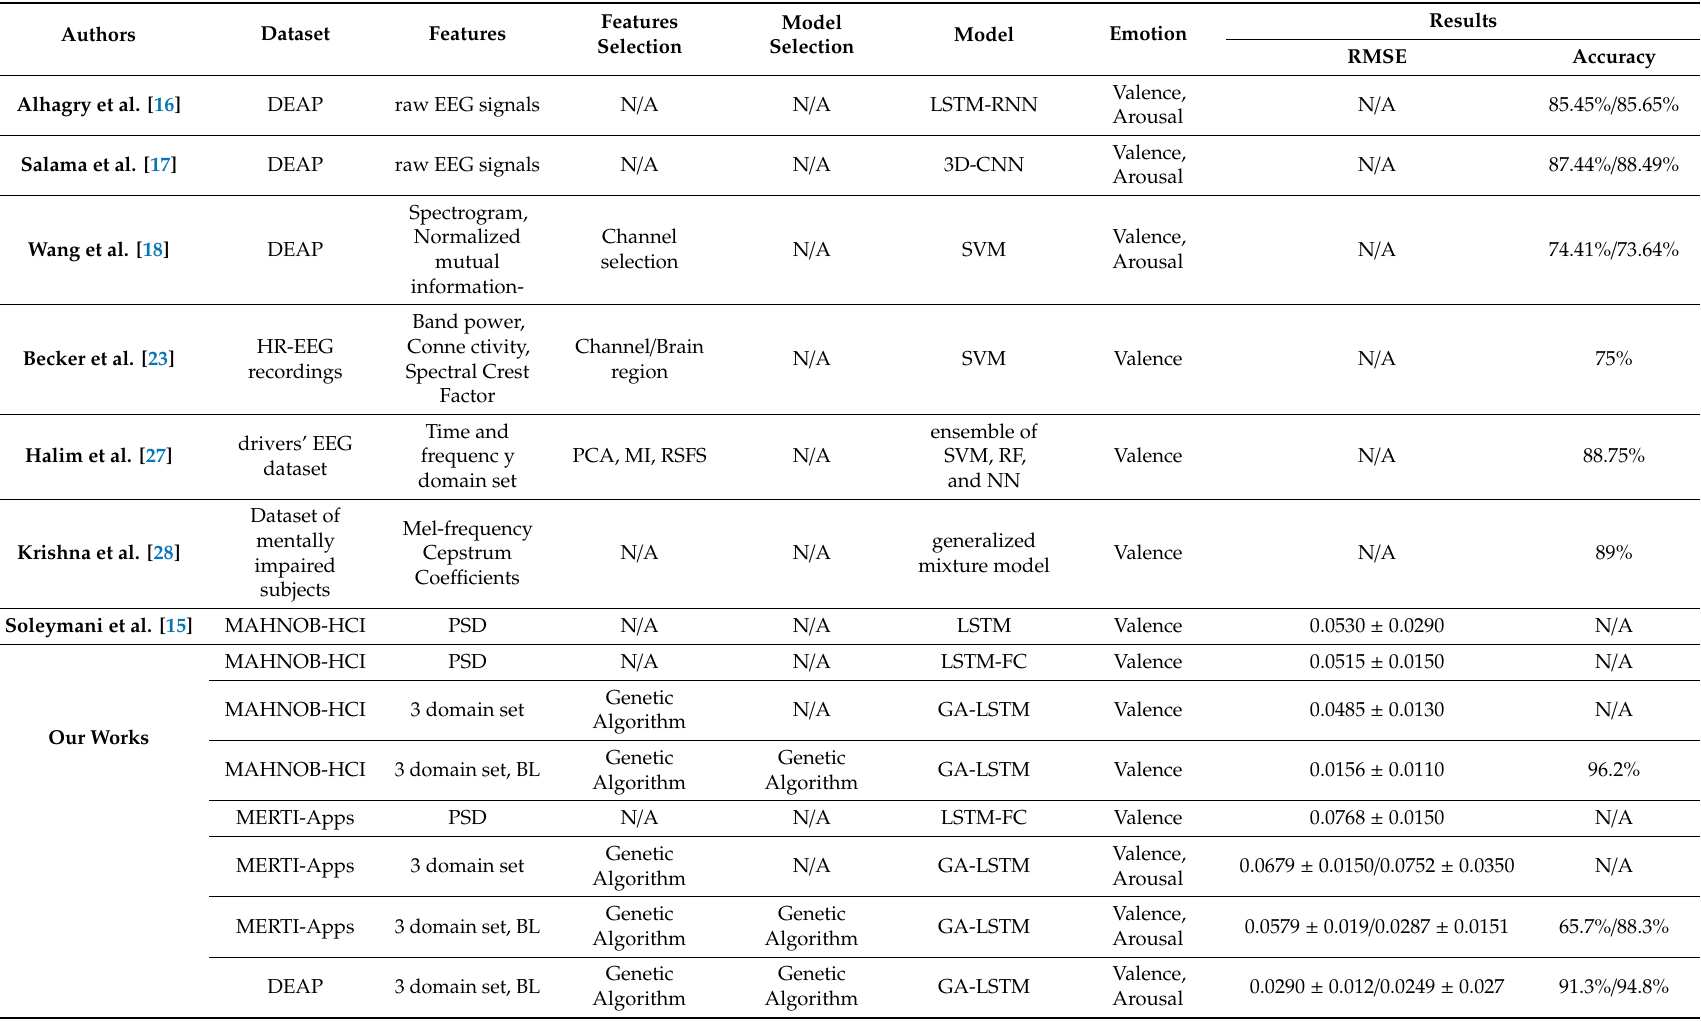
Table 6. Experimental results of discrete and continuous emotion recognition according to the model architectures and